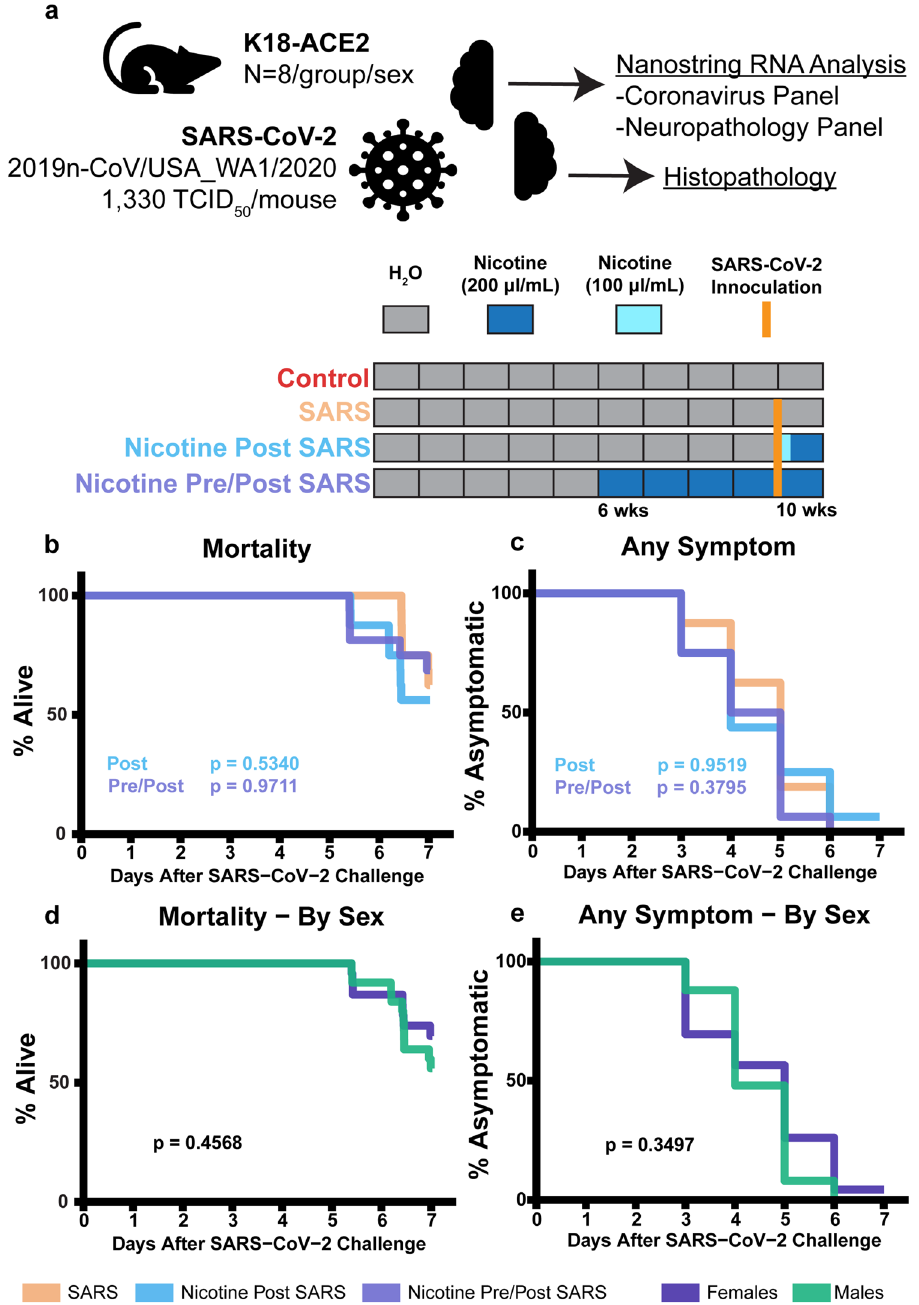
Figure 1. Nicotine exposure did not alter moribundity of mice inoculated with SARS-CoV-2. ( a ) Study design. Each rectangle of represents one week with regular water (grey), 200 µl/mL nicotine (blue), or 100 µl/ mL nicotine (cyan) for drinking. Weeks refer to current mouse age. ( b – e ) Cox proportional hazard models comparing time to mortality or symptom appearance by treatment or sex. The blue Post p -value compares survival curves between SARS and Nicotine Post SARS groups. The purple Pre/Post p -value compares survival curves between SARS and Nicotine Pre/Post SARS